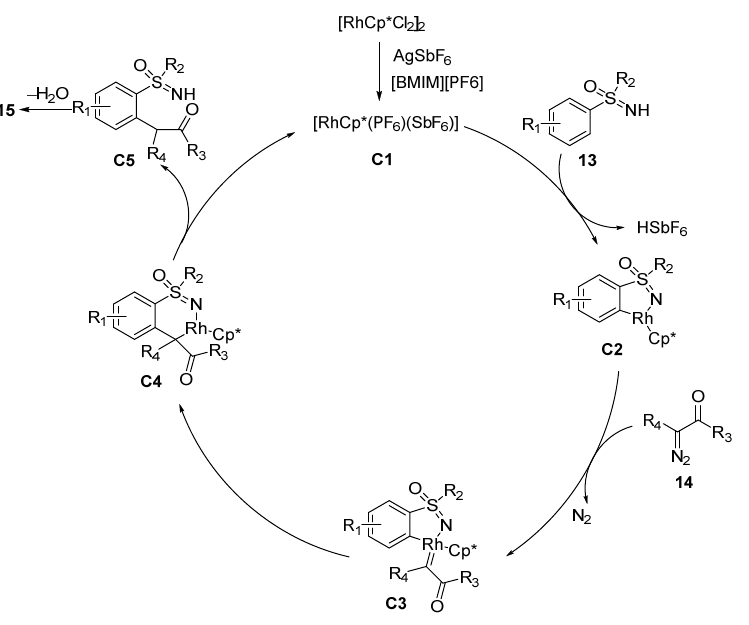
Scheme 7. Sustainable Rh(III) ‐ catalyzed C–H activation/cyclization of sulfoximines to form 1,2 ‐ ben